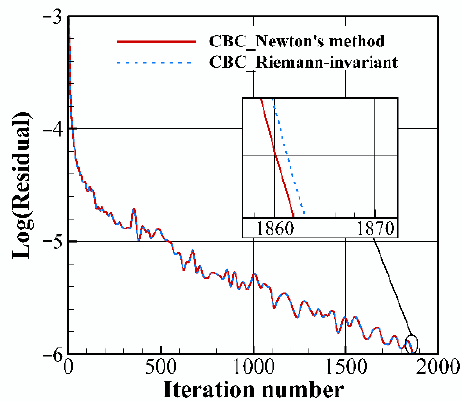
Figure 3. Convergence histories of LSCC simulation.